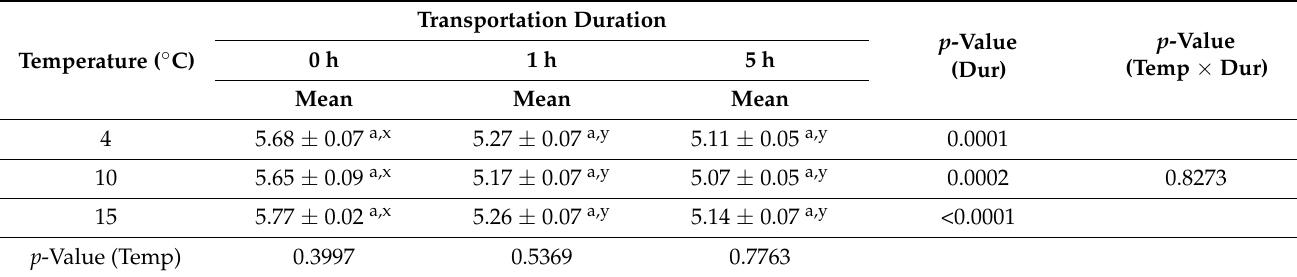
Table 4. Effects of transportation temperatures (4 ◦ C, 10 ◦ C, and 15 ◦ C) for two different transportation durations (1 and 5 h) on the pH values of pectoralis major muscles in broiler chickens.